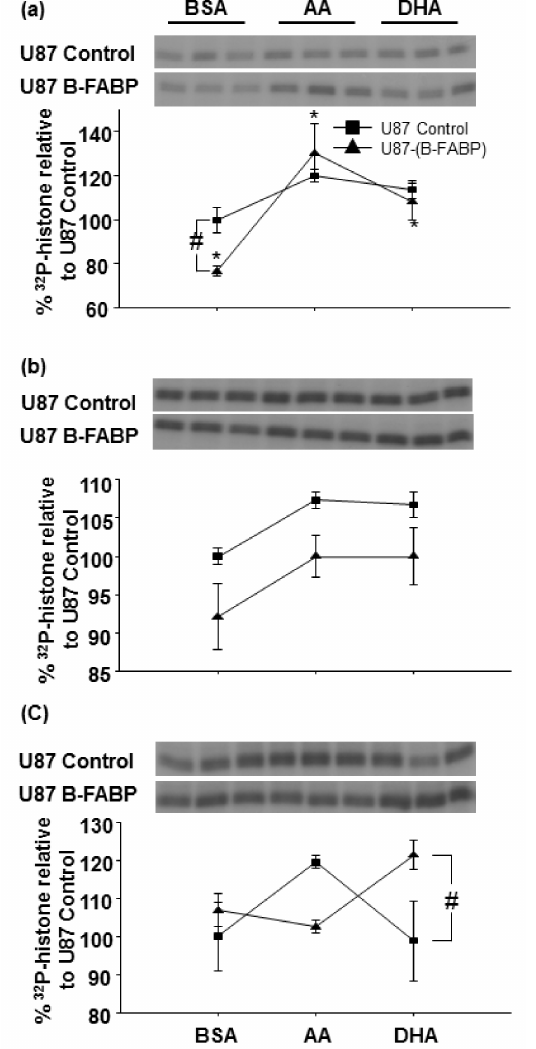
Figure 3. Arachidonic acid (AA) and docosahexaenoic acid (DHA) modulate conventional and atypical PKC activities in U87 cells expressing B-FABP. Two-way effect plot of least square mean PKC activity ( y axis) calculated as percentage of U87 control BSA-treated cells vs treatment ( x axis) for ( a ) conventional PKC activity; ( b ) novel PKC activity; and ( c ) atypical PKC activity measured in U87 cells transfected with either empty pREP4 vector (U87 Control) or a pREP4-FABP7 expression construct (U87 B-FABP). Cells were treated with 60 µ M BSA, 60 µ M AA, or 60 µ M DHA ( n = 3–6/treatment). # indicates